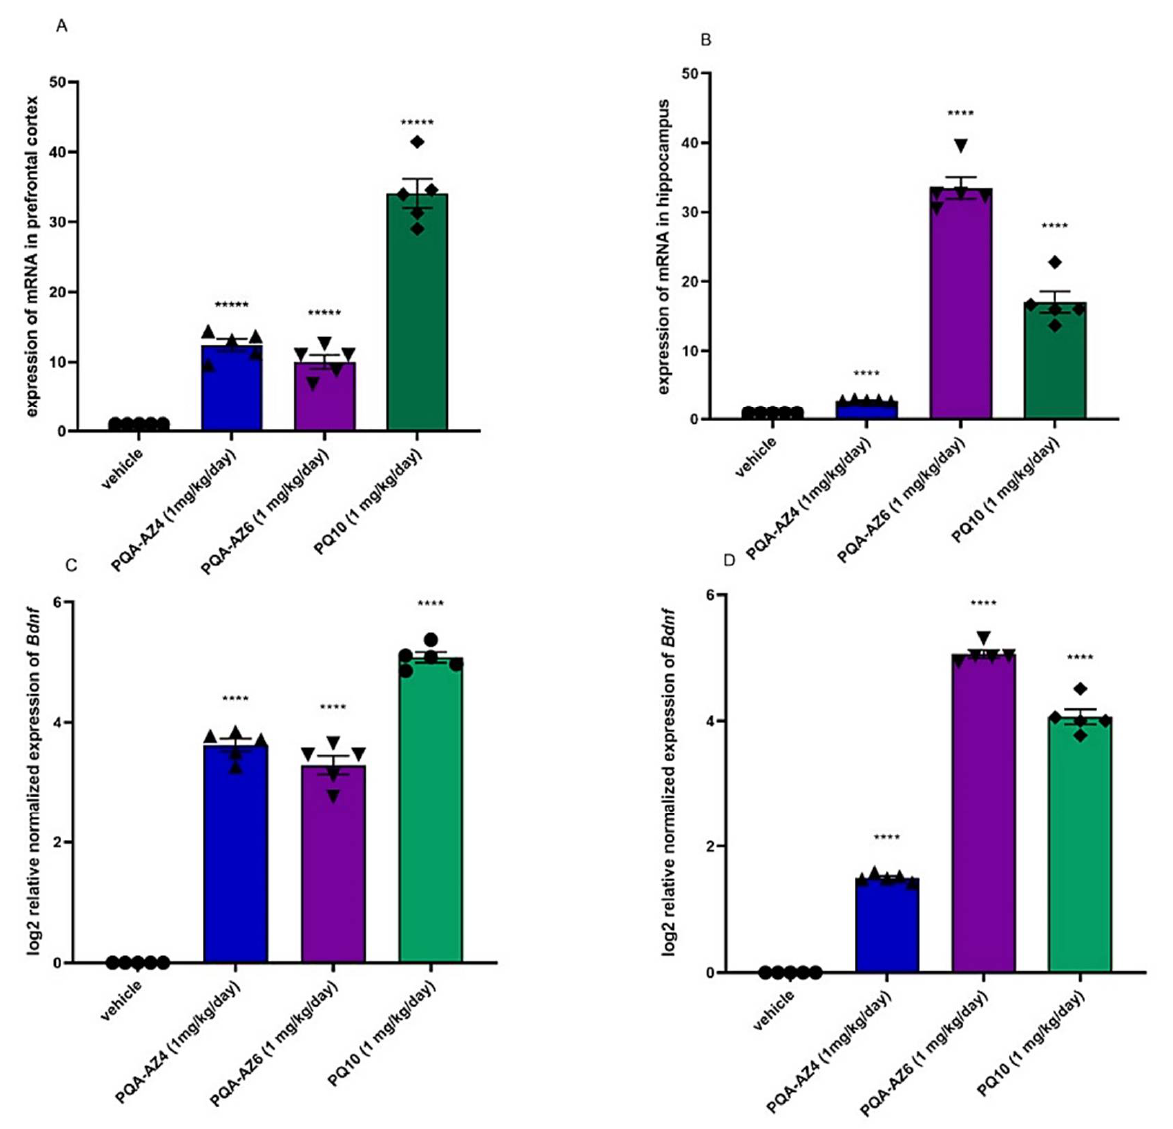
Figure 2. Effects of repeated administration of PQA-AZ4, PQA-AZ6, and PQ-10 on expression and relative normalized expression of the Bdnf gene in the prefrontal cortex (( A , C ), respectively) and the hippocampus (( B , D ), respectively) in rats. PQA-AZ4, PQA-AZ6, and PQ-10 were administered i.p. once daily to male rats for 21 consecutive days and the tissues were collected immediately after the FST. Data represent the mean ± SD, n = 5 rats per group; statistical analysis was performed using the Student’s t -test; **** p < 0.0001, ***** p < 0.00001 vs. respective vehicle-treated group.